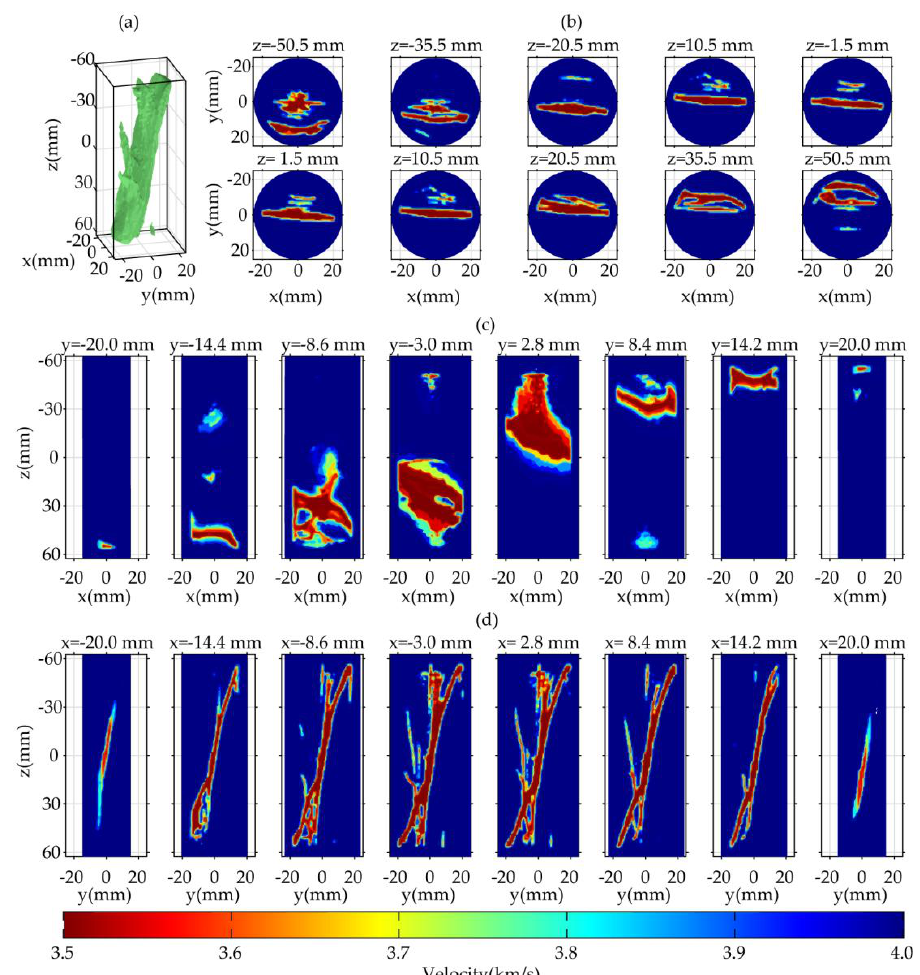
Figure 6. The velocity model. ( a ) the 3D segmented image; ( b ) the transverse-view profile; ( c ) the coronal-view profile; and ( d ) the sagittal-view profile. The caption of each sub-image in ( b – d ) represents the profile position.